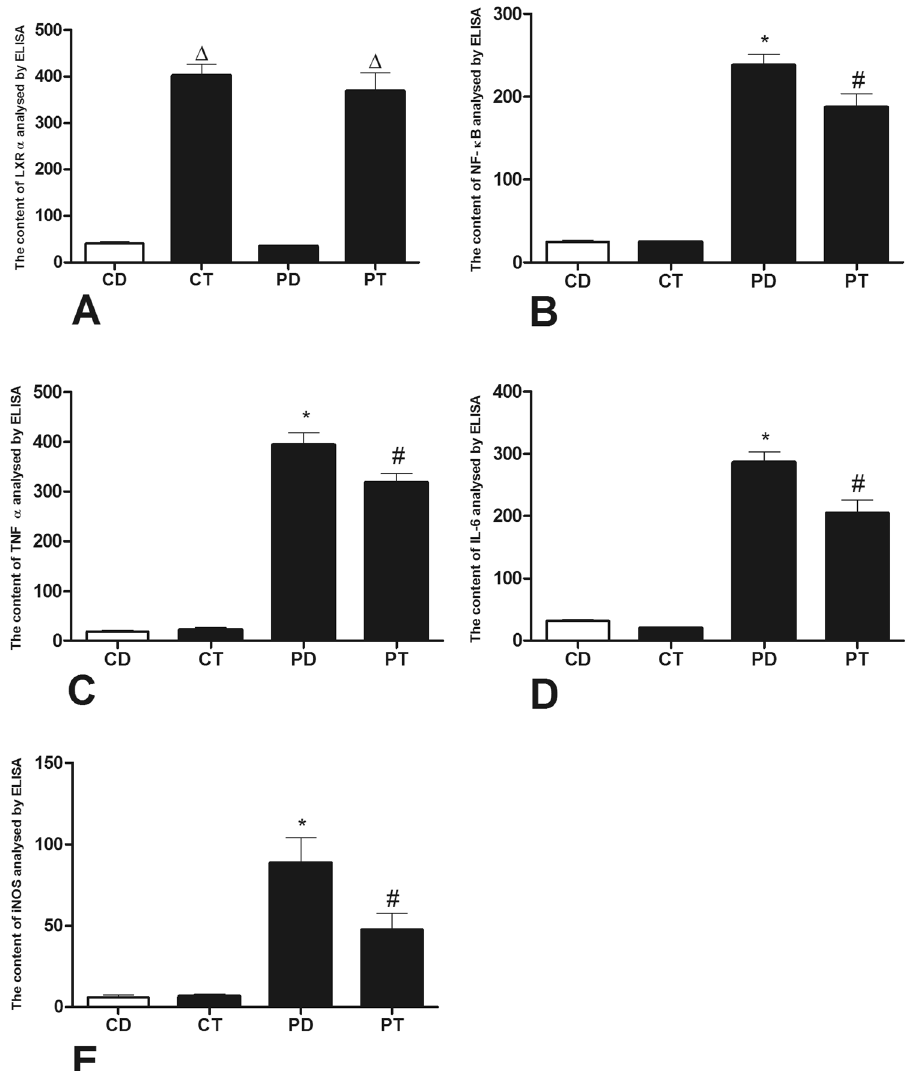
( A ), NF- κ B ( B ), TNF- α ( C ), IL-6 ( D ), and iNOS ( E ) protein expression in rats. Samples were obtained from rat right ventricular myocardiocytes. (CD: rats treated with NS + DMSO, CT: rats treated with NS + T0901317, PD: rats treated with MCT + DMSO, PT, rats treated with MCT + T0901317). (n = 6, Δ : vs CD/PD P < 0.05, * vs CD P < 0.05, # vs PD P <